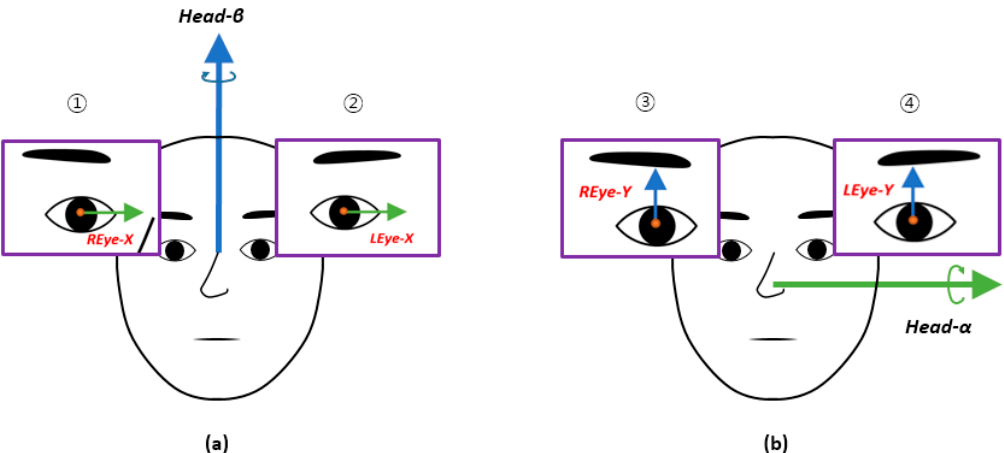
Figure 4. A pair of axes was used to obtain the correlation coefficient: ( a ) horizontal and ( b ) vertical.